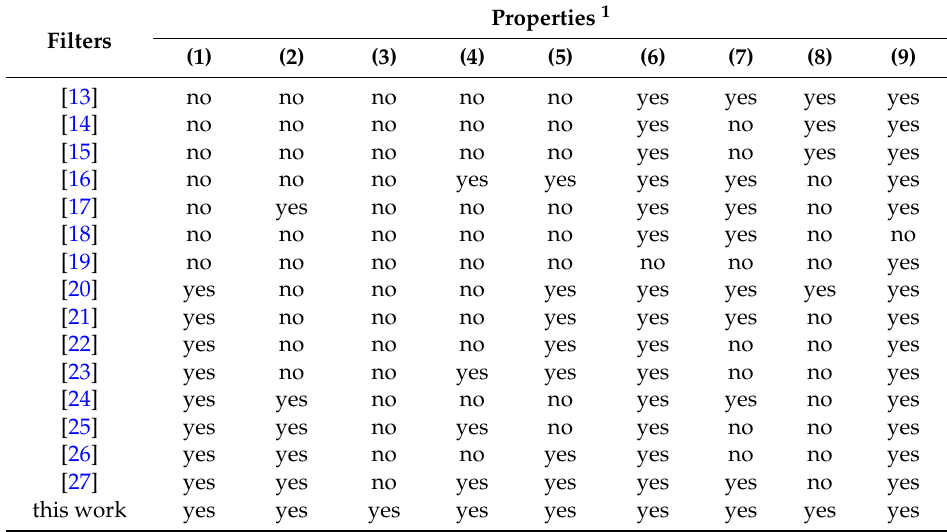
Table 2. Characteristic comparisons with previous reported mixed-mode